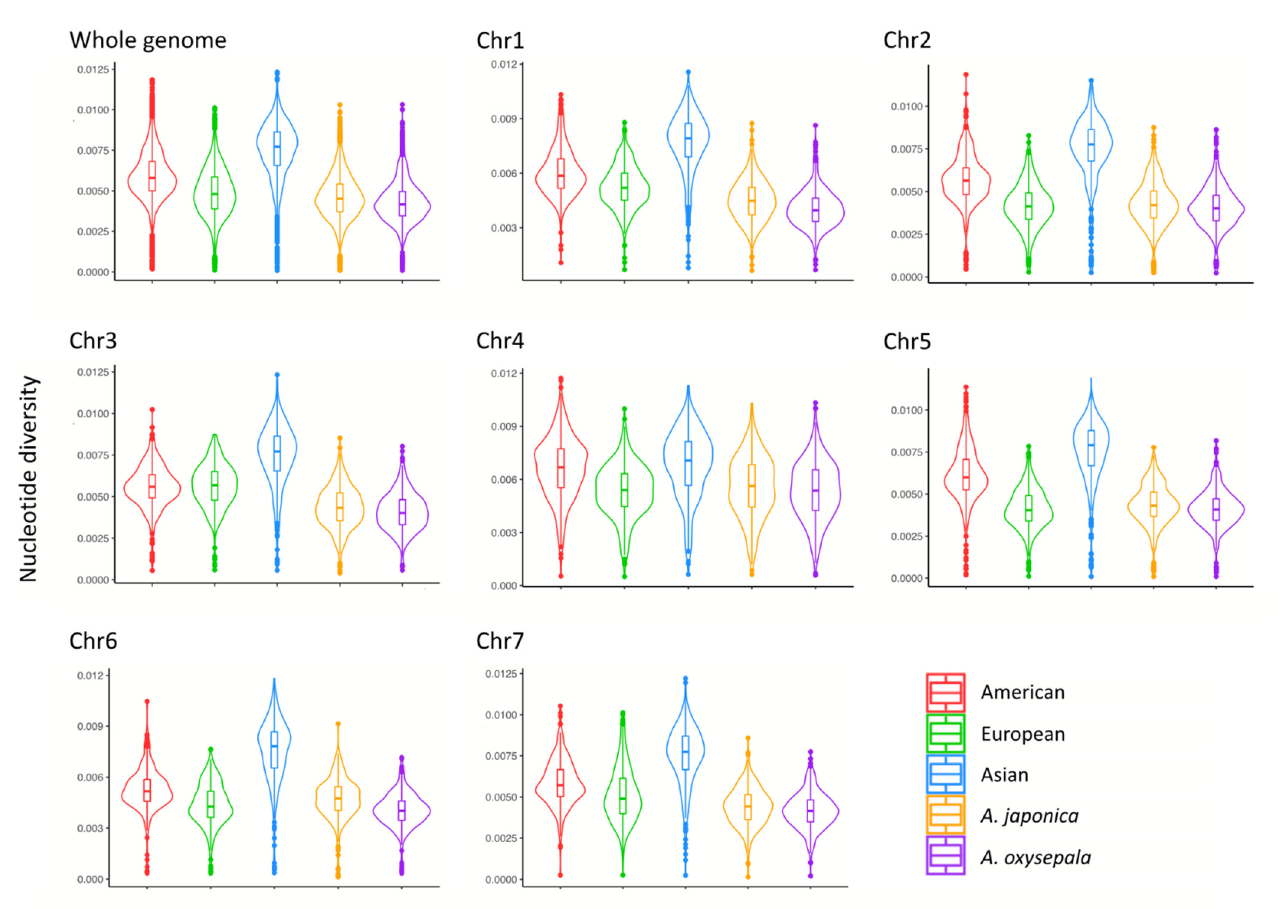
Figure 2. Distribution of nucleotide diversity ( π ) at the whole-genome level and the per-chromosome level. Nucleotide diversity was estimated for each lineage pooling corresponding species, as well as for A. japonica and A. oxysepala .